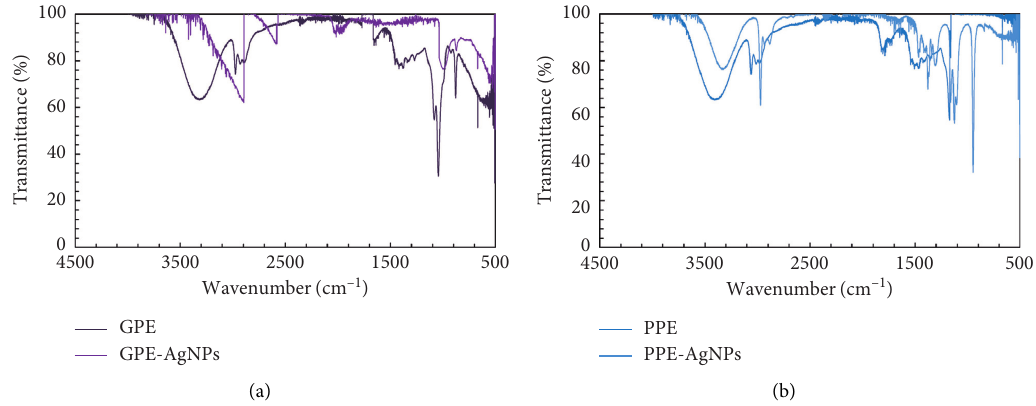
Figure 10: FT-IR spectra of aqueous black currant, apricot, grape pomace, and pomegranate peel extracts and GPE-AgNPs and PPE-AgNP.